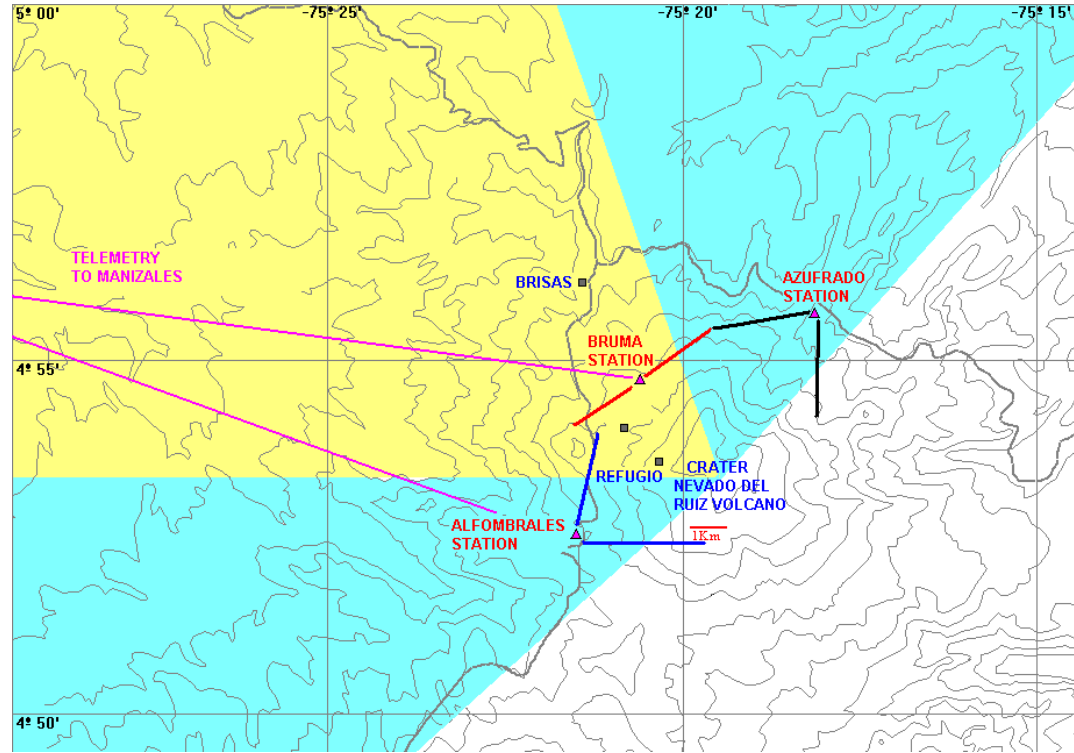
Figure 1. Topographic map (contour levels every 200m, the upper contour level is at 5200m, Bruma station is at 4800ma . s . l . ) showing the location of Nevado del Ruiz volcano (Colombia) and the three NOVAC stations used for gas monitoring. The blue, red and black lines depict the viewing directions of the scanning DOAS systems. The two original instruments at Alfombrales Station and Bruma Station were installed in November 2009 and transmit data in real time to the volcanological observatory located at Manizales city. The third instrument at Azufrado Station was installed in May 2012; its data are not included in this paper. The yellow background colour shows the wind direction for approximately 70% of the time, and the light blue shaded area shows the wind direction for the remaining